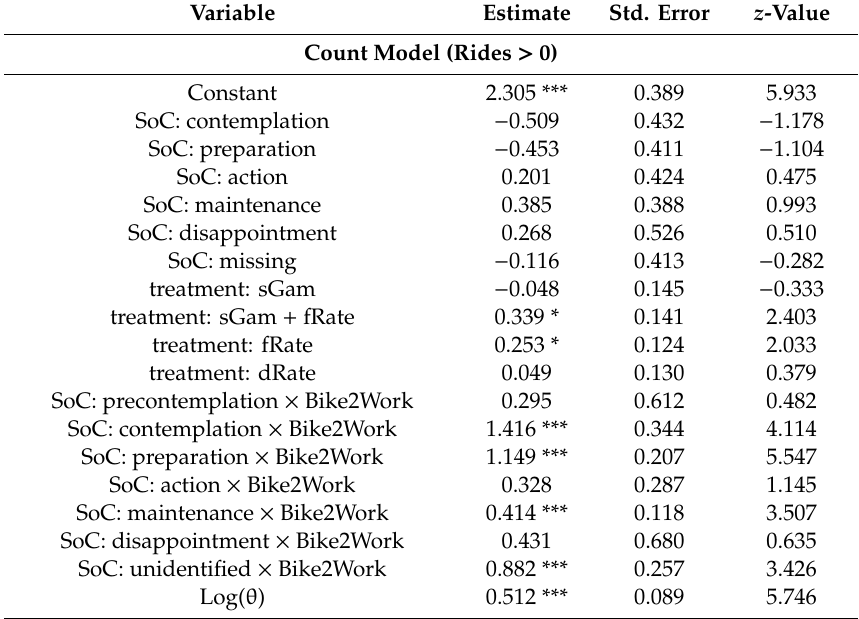
Table 3. Zero-inflated negative binomial regression model for rides to work / school recorded in the experiment (dependent variable: number of rides to work or school recorded in the app during the